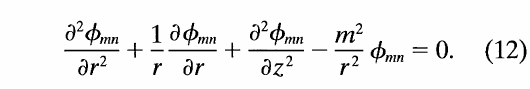
FIGURE 1 Liquid-filled tank with the flexible